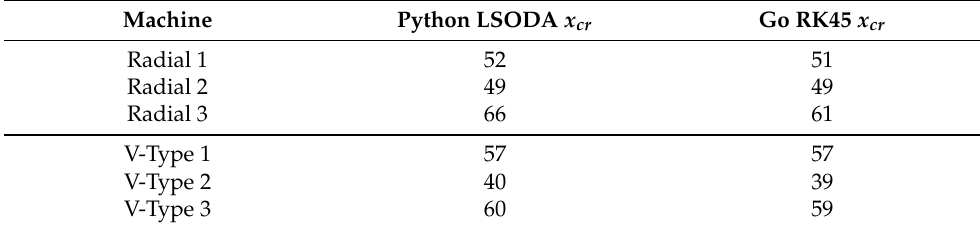
Table 6. Comparing Go and Python ODE solvers for predicting x cr